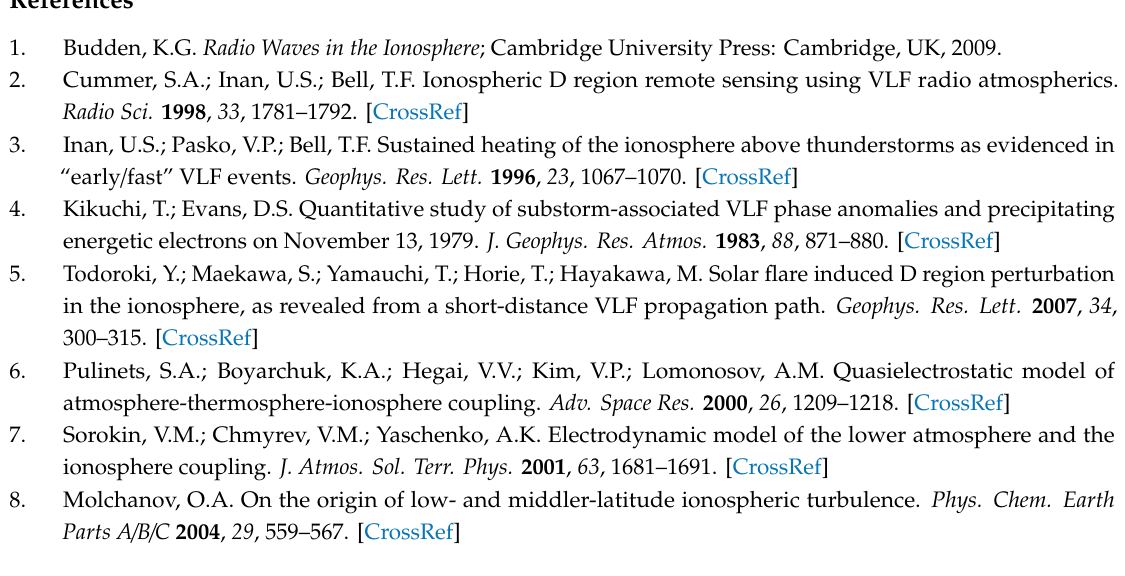
Figure S1: The observed Ez amplitude in the path between NOV and Ya’an on 5 April, Figure S2: Nighttime Fluctuations analysis for April 2010 for the Yushu earthquake on 14 April 2010 at the path between NOV-Tonghai and Ya’an at F2 and F3. Figure S3: Nighttime Fluctuations analysis for April 2010 for the Yushu earthquake on 14 April 2010 at the path between NOV-Tonghai and Ya’an when excluded the data on 6, 7, 12